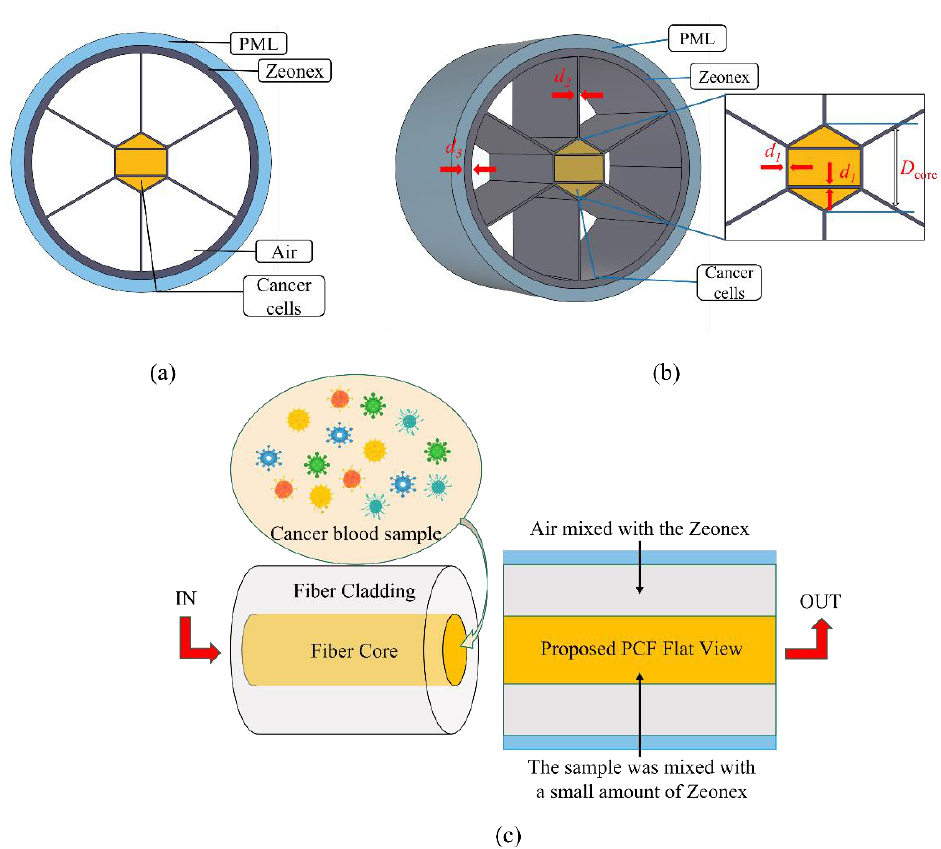
Figure 1. Schematic of the designed MSF structure. ( a ) 2D patterning of fiber intersecting surface. ( b ) 3D structure of optical fiber, with critical distances denoted. ( c ) Diagram of analytes and incident light propagation in the fiber core.